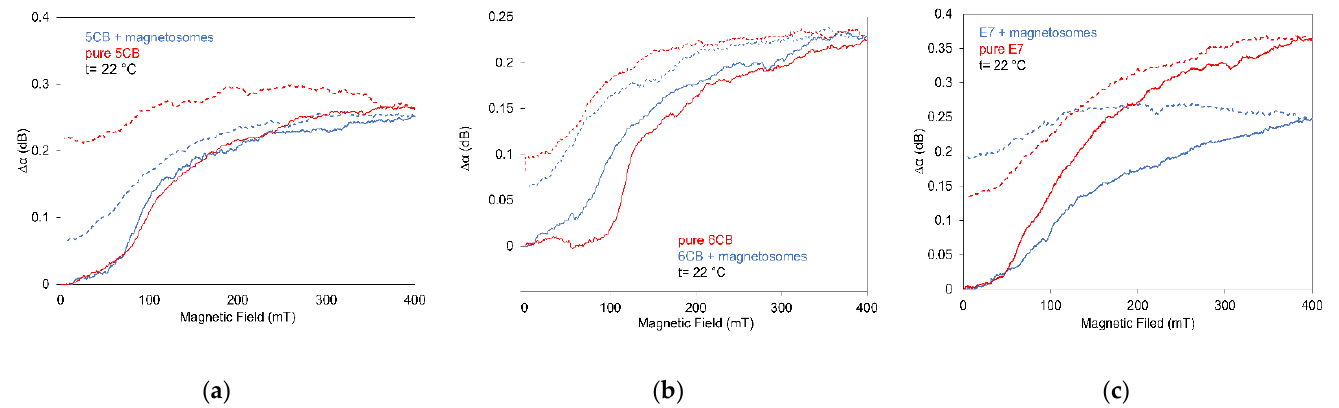
Figure 7. Effect of magnetic field on SAW attenuation for 5CB ( a ) 6CB ( b ) and E7 ( c ) doped with magnetosomes of concentrations 0.2 wt% with that of corresponding pure LCs for increasing (full lines) and decreasing (dushed lines) magnetic field.